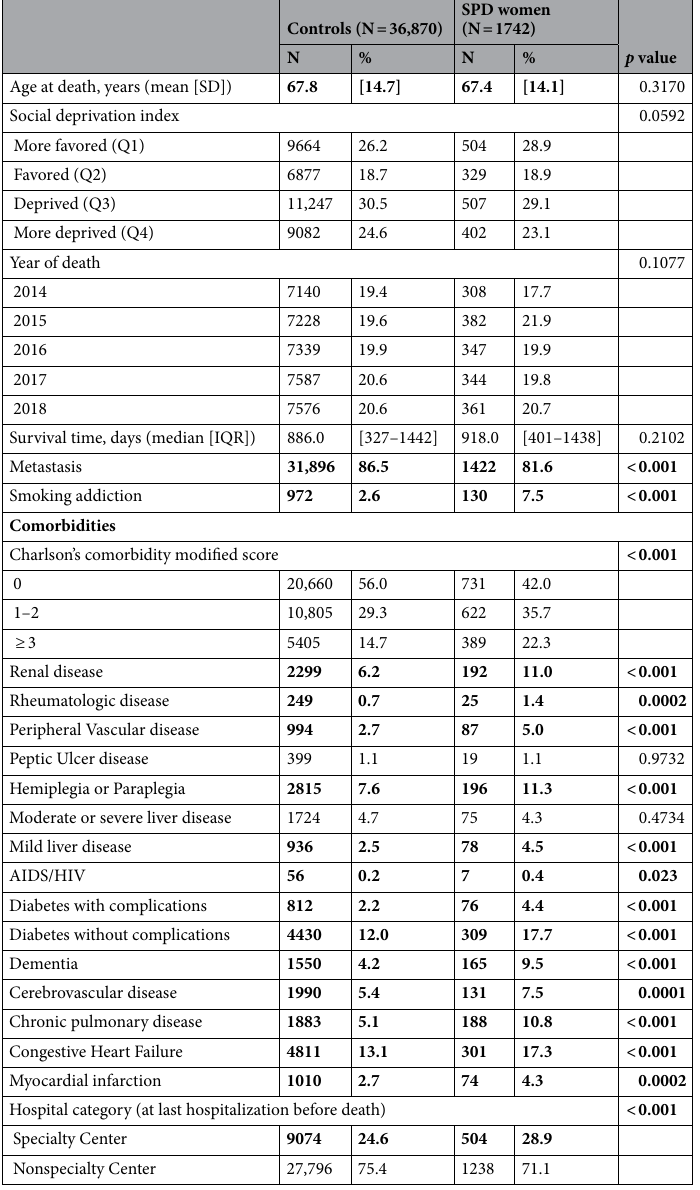
Table 1. Characteristics of the 1742 women who died from their terminal breast cancer between 2014 and 2018 in France with diagnosis of severe psychiatric disorder* (SPD) compared to the 36,870 controls without SPD. Significant results are in bold. N number of patients, % percentage, IQR interquartile range, Q quartile (from Q1 to Q4), SD standard deviation. *Defined by a diagnosis of recurrent major depression, bipolar disorder or schizophrenia on the study